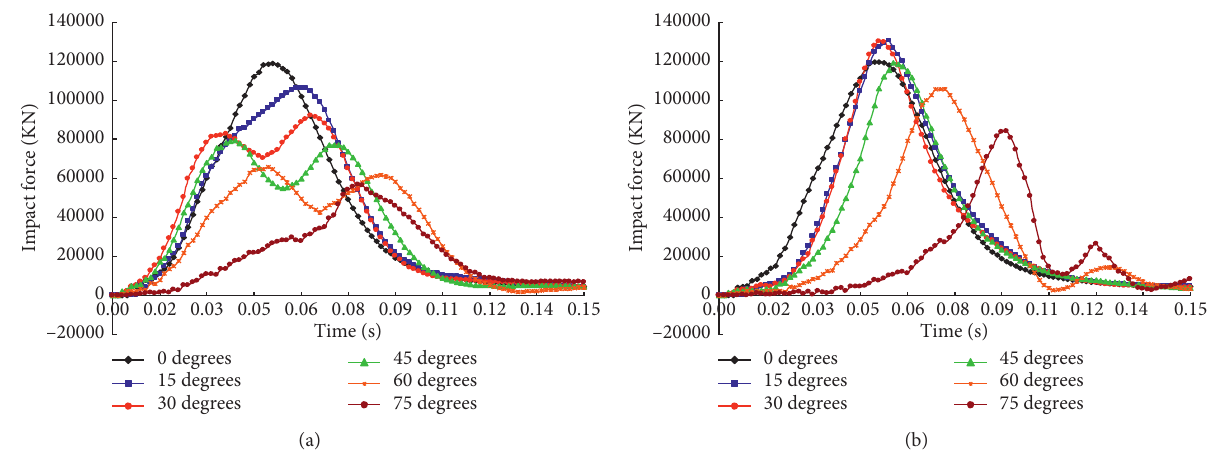
Figure 11: The time-domain responses of impact of supporting ropes with different impact angles. (a) First support rope. (b) Second supporting rope.